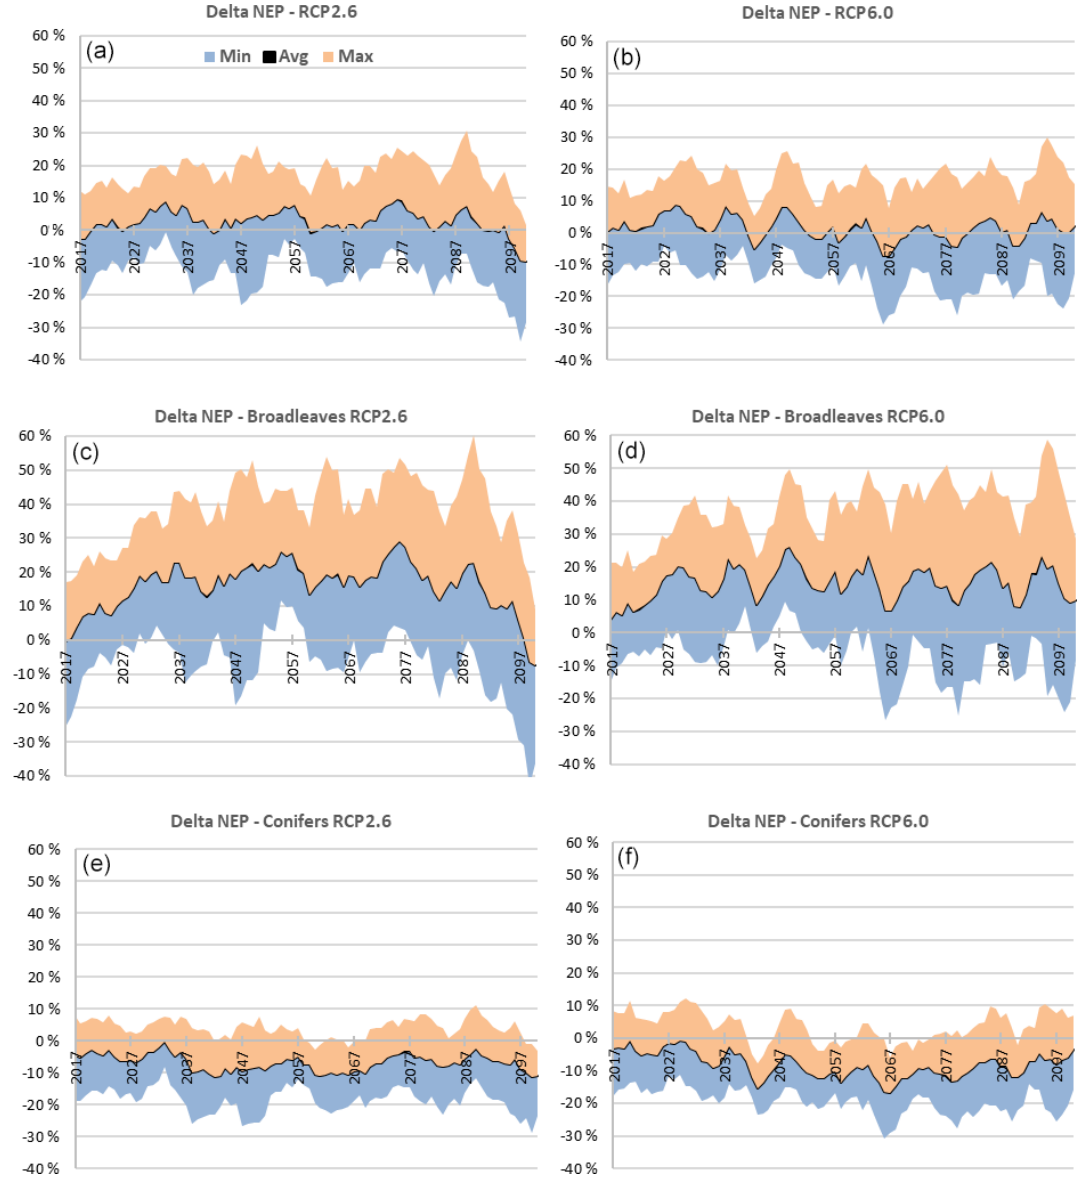
Figure 7. Average annual rate of variation in the net ecosystem production (NEP), compared to the RS, derived from the four climate models, at the EU level (a, b) , for broadleaved species and for conifers, under different RCP scenarios. Minimum (min) and maximum (max) percentage values correspond to the interval between the minimum and maximum difference with the RS for each year. All values are reported as 5-year moving